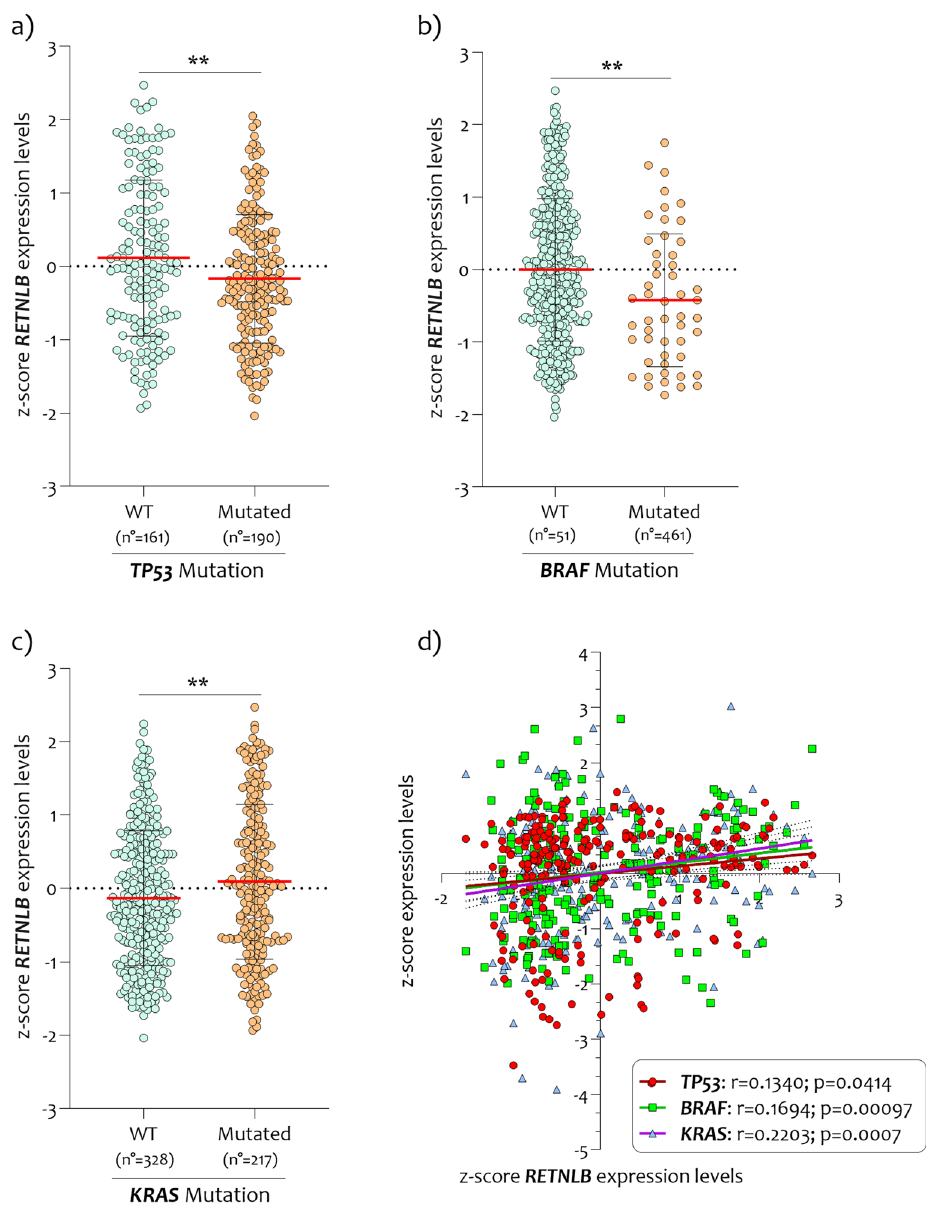
Figure 3. RETNLB expression levels correlate to BRAF, TP53, and KRAS in CRC biopsies. ( a ) RETNLB expression levels analysis in CRC patients TP53 mutated (n = 190) and wild-type (n = 161); ( b ) RETNLB expression levels analysis in CRC patients BRAF mutated (n = 51) and wild-type (n = 461); ( c ) RETNLB expression levels analysis in CRC patients KRAS mutated (n = 328) and wild-type (n = 217); ( d ). Data are expressed as z-score intensity expression levels (means and SD) and presented as dot plots. p values < 0.05 were considered as statistically significant (**p <